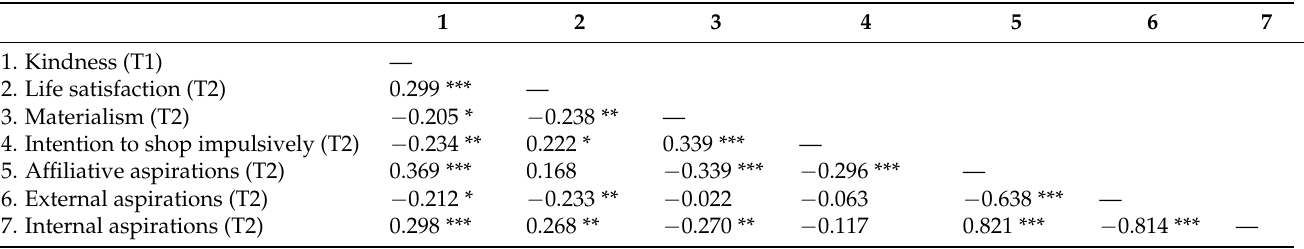
Table 1. Correlations between the variables used in the study.